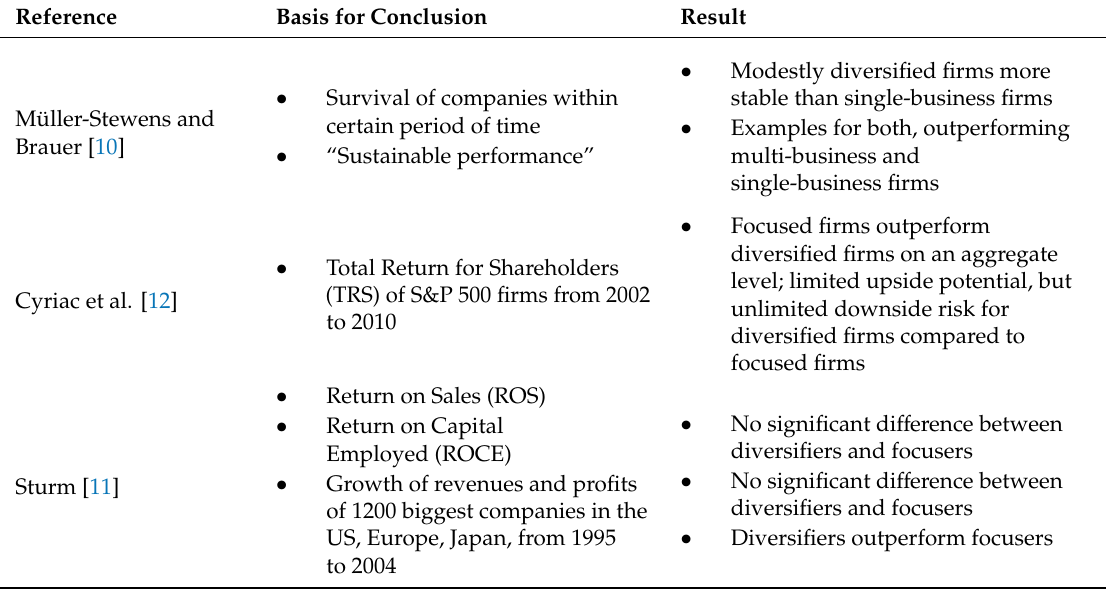
Table 1. Aggregation of the main findings regarding the performance of diversified vs. focused